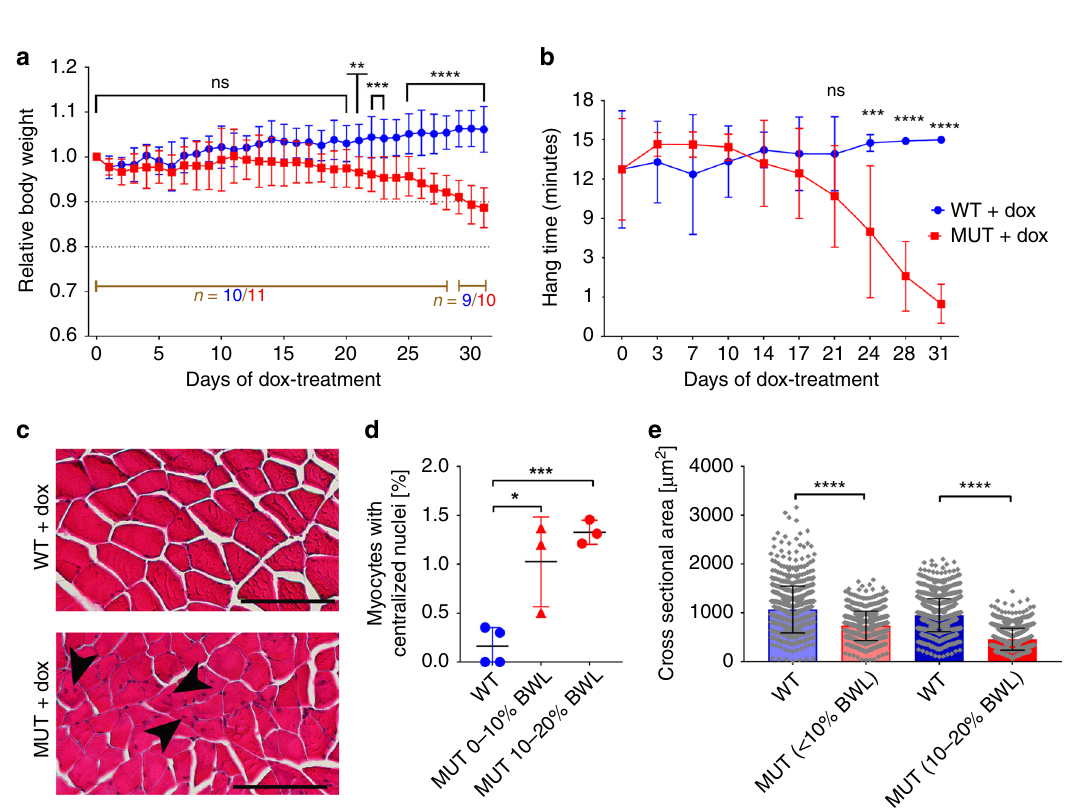
Fig. 2 Titin depletion leads to muscle remodeling and reduction in muscle strength. a Alterations in body weight with time in MUT and WT Ttn tm1c ; ACTA1-rtTA;tetO-cre mice during dox-treatment. Data were normalized to the body weight immediately before dox-treatment. Beginning around day 21, there was a signi fi cant difference between WT and MUT ( p = 0.0068; for WT, n = 10 animals (9 for the last three time points) and for MUT, n = 11 animals (10 for the last three time points)). b Alterations in muscle strength during dox-treatment of MUT vs . WT mice measured in the 4-limb hanging test. Hang time was plotted against duration of treatment. From day 24 of dox-treatment onward, MUT mice had signi fi cantly reduced hang times ( p = 0.0004; n = 7 animals/group). c Representative cross sections (out of 8 – 10 images recorded per condition) of hematoxylin and eosin stained M. triceps brachii from WT and MUT mice after ~30 days of dox-treatment. Arrowheads point to centralized nuclei. Bars, 100 µ m. d Percentage of myo fi bers presenting with centralized nuclei in dox-treated WT ( n = 4) and MUT mice with a body weight loss (BWL) of <10% ( n = 3) and 10 – 20% ( n = 3), respectively, relative to body weight before treatment. e Cross-sectional area of myo fi bers ( n = 630) from WT and MUT Ttn tm1c ;ACTA1-rtTA;tetO-cre mice (~30 days of dox-treatment); n = 3 mice/group. Data are mean± SD. **** p < 0.0001; *** p < 0.001; ** p < 0.01, in 2-way-ANOVA, followed by Sidak ’ s multiple comparisons test ( a and b ); unpaired, two-tailed Student ’ s t- test (d); or two-tailed Mann – Whitney test ( e ). Source data are provided as a Source Data fi f). Thus, the highly ordered repetitive sarcomere struc- (ACTN2, Fig. 3b, e, f) and A-band-based myosin heavy chain ture depends on the presence of Z-disc-anchored TTN iso- (MyHC) (Fig. 3d). Furthermore, both the TTN-kinase domain forms, whereas Cronos does not prevent deterioration of (M-band) and the Cronos N-terminus (I/A-junction) lost sarcomeres. their regular striated appearance in affected MUT cells (Fig. 3e,